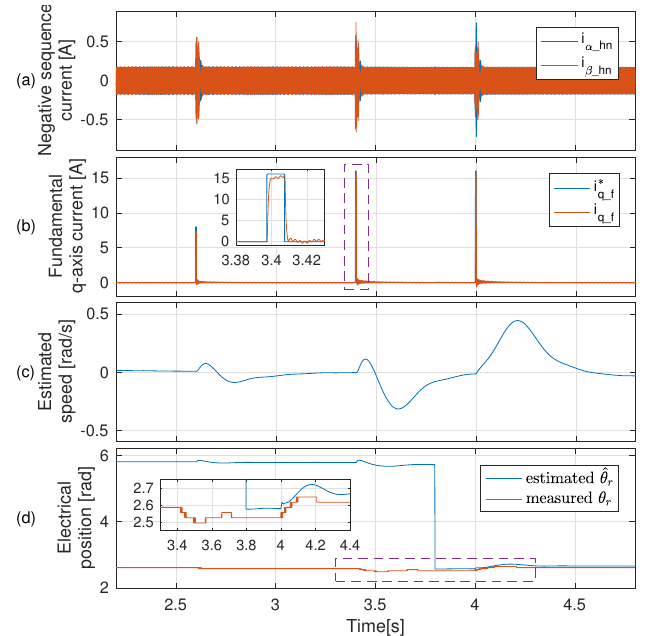
Figure 15. Initial rotor position estimation with inertia load of 6 g · m 2